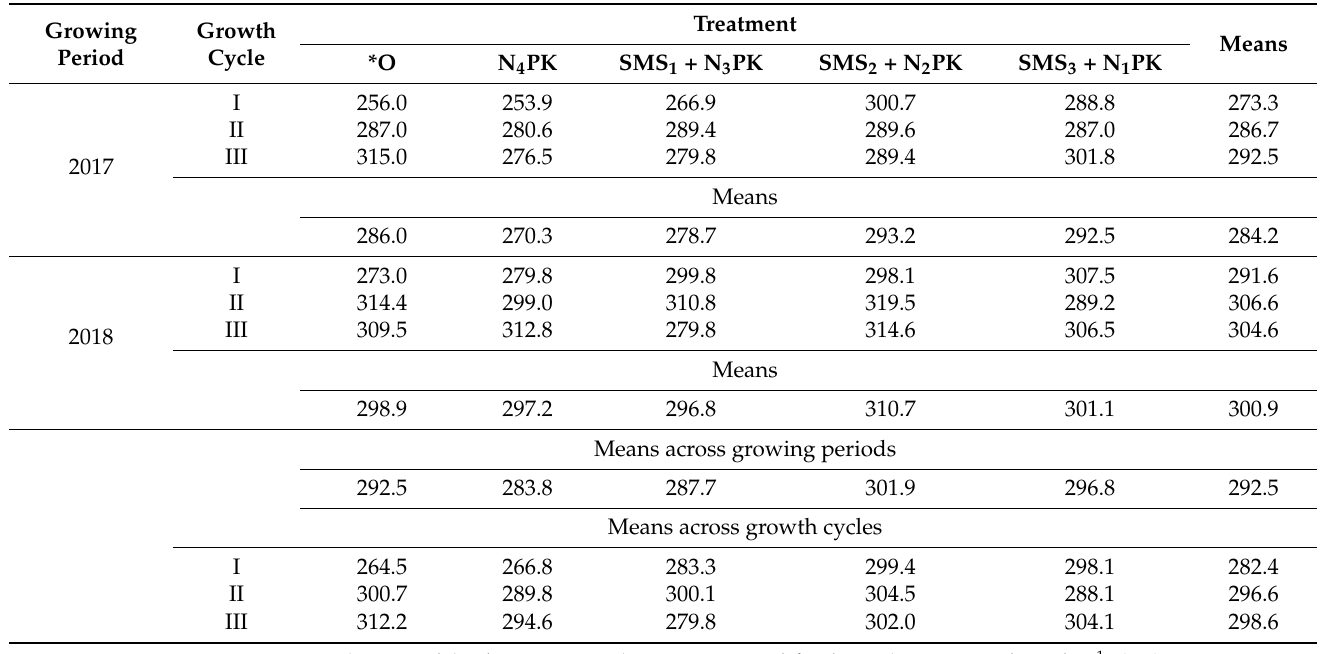
Table 5. The effect of fertilizer treatment, growing period and growth cycle on Festulolium braunii crude fiber content (g · kg − 1 DM).